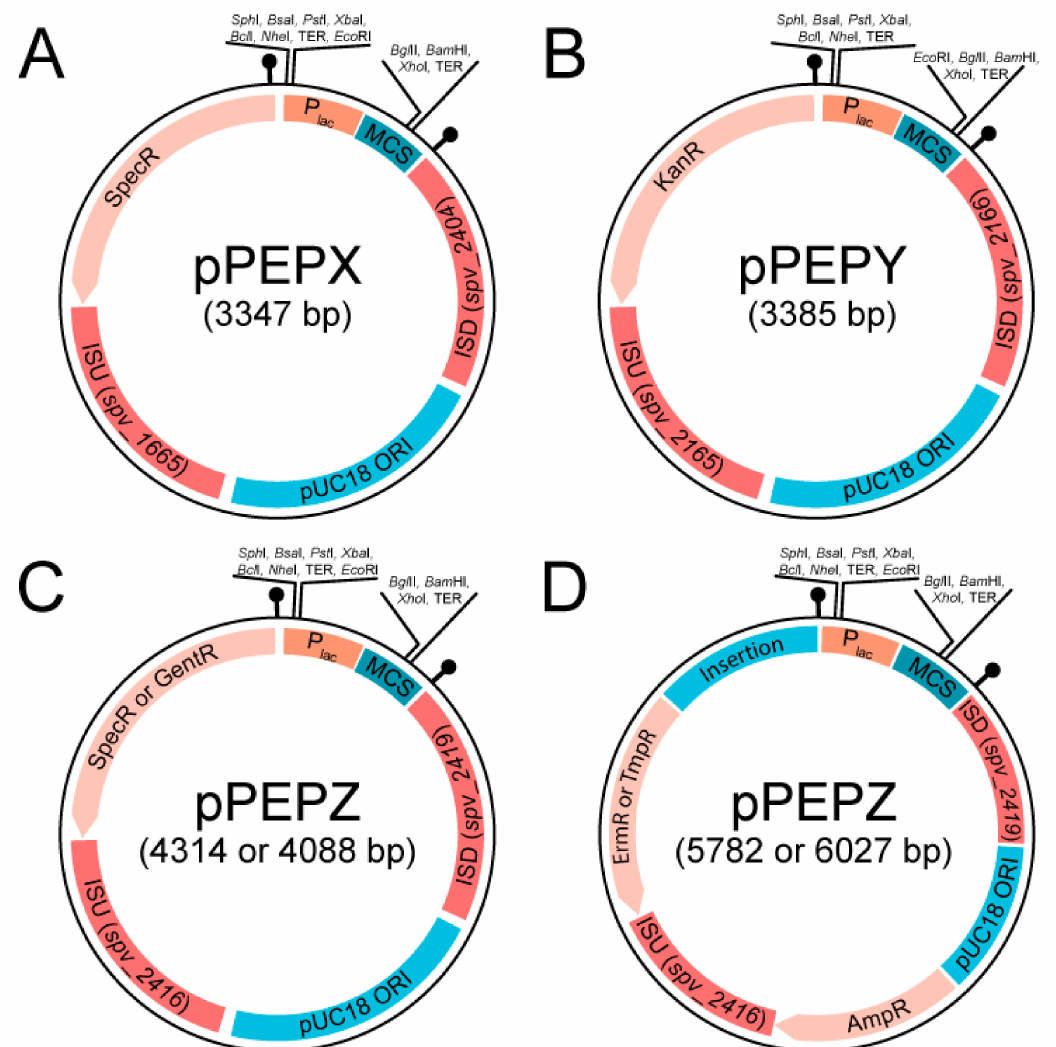
Figure 1. Diagram of general layout for various constructed PEP vectors. All PEP vectors have the same IPTG inducible promoter as well as the same pUC18 origin of replication which is permissive in E. coli , but not in S. pneumoniae . All vectors have a multiple cloning site featuring the BglBrick cloning method and integration regions that are transcriptionally silent based on RNA-seq data. Each promoter and MCS is flanked by strong terminators. ( A ) The pPEPX vector has a spectinomycin resistance marker and integration regions of approximately 500 bp in length and integrates at 295.4 ◦ around the D39V chromosome near amiF ( spv_1667 ). ( B ) The pPEPY vector has a kanamycin resistance marker and integration regions of approximately 500 bp in length and integrates at 74.6 ◦ around the D39V chromosome near spv_0422 . ( C ) Two pPEPZ vectors have either a spectinomycin or gentamycin resistance marker and integration regions of approximately 1000 bp in length and integrates at 303.9 ◦ around the D39V chromosome near spv_1736 . ( D ) Two pPEPZ vectors have either an erythromycin or trimethoprim resistance marker along with an ampicillin marker for selection in E. coli . A nonfunctional E. coli chromosomal sequence insertion between the S. pneumoniae selection marker and the promoter is